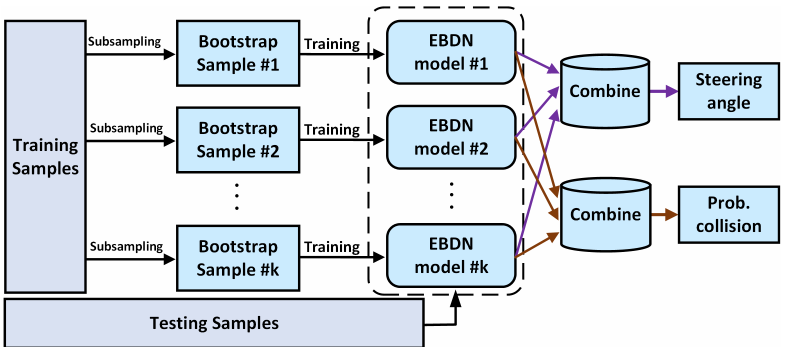
Figure 3. Schematic diagram of EBDN model. Each EBDN performs a separate training on each sample set generated by the bagging method and finally fuses all outputs through an ensemble mechanism to obtain the final results.